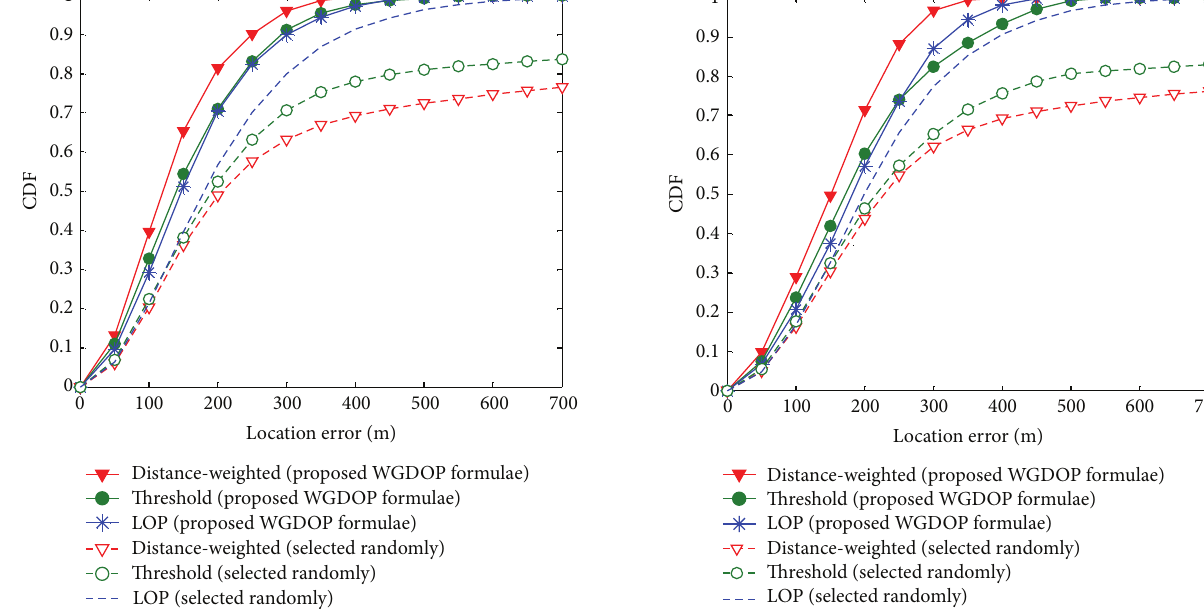
Figure 3: Comparison of location error CDFs using the subset with proposed minimum WGDOP approximation and the subset selected four BSs randomly (Type 1).